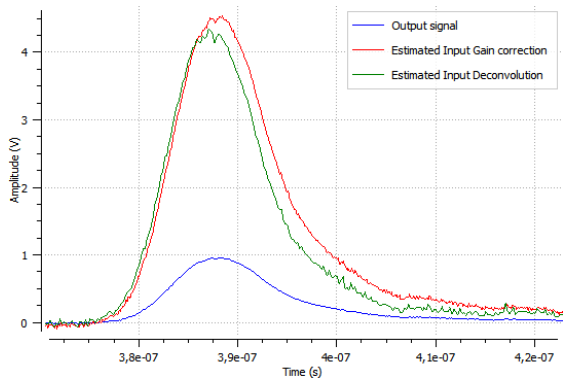
Fig. 6. Output signal (blue) and estimated inputs using a simple gain correction (red) and an inverse filter deconvolution (green).